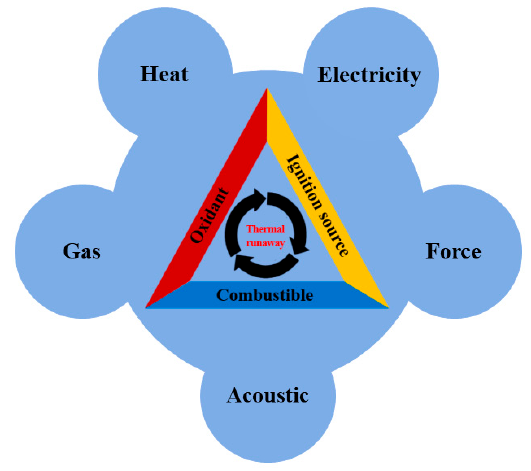
Figure 1. Hazard characteristics of ba tt ery